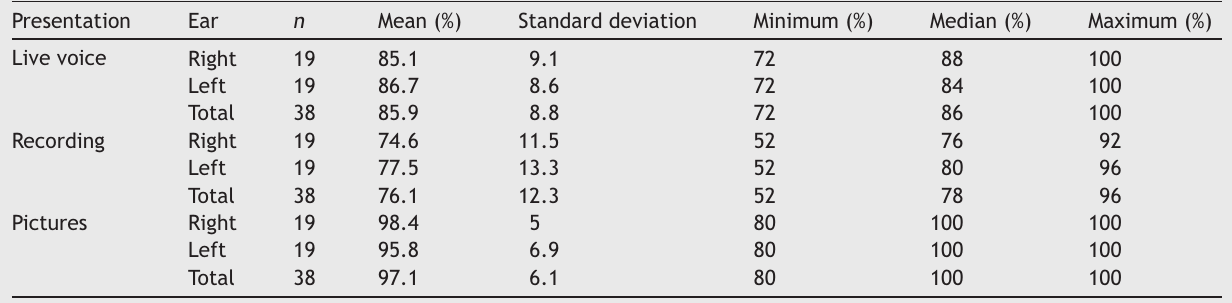
Descriptive statistics values for the percentages of correct answers in the Speech Recognition Percentage Index by